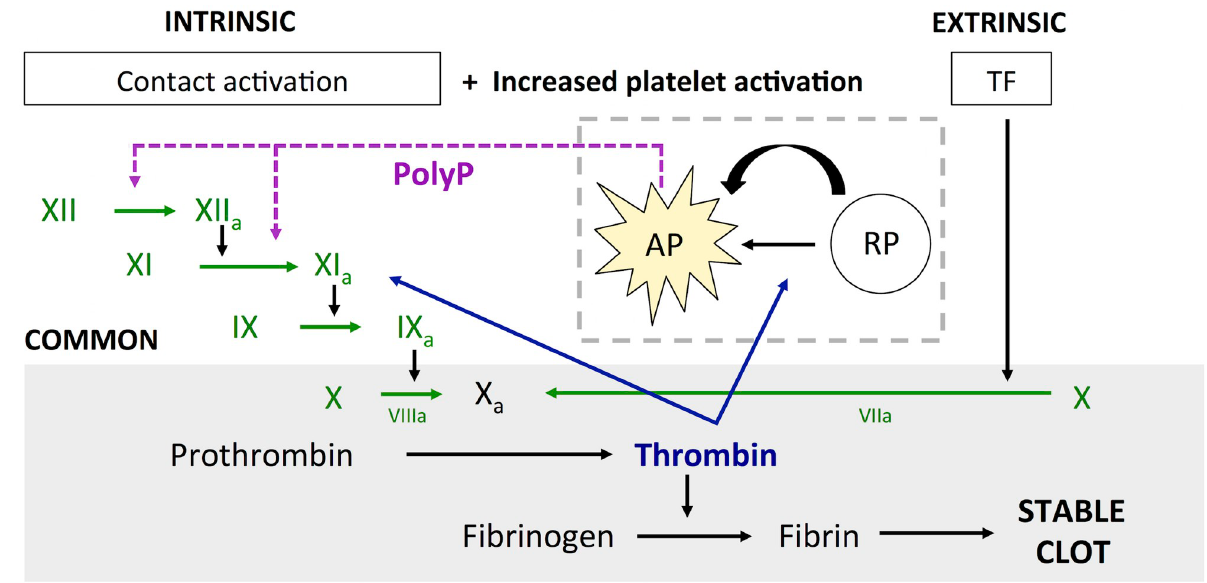
Fig 1. Simplified representation of the coagulation cascade. Intrinsic and extrinsic pathways and proposed pathway for aneurysm induced thrombosis (increased platelet activation + PolyP). TF = Tissue Factor, AP = Activated platelet, RP = Resting platelet, PolyP = Polyphosphate.